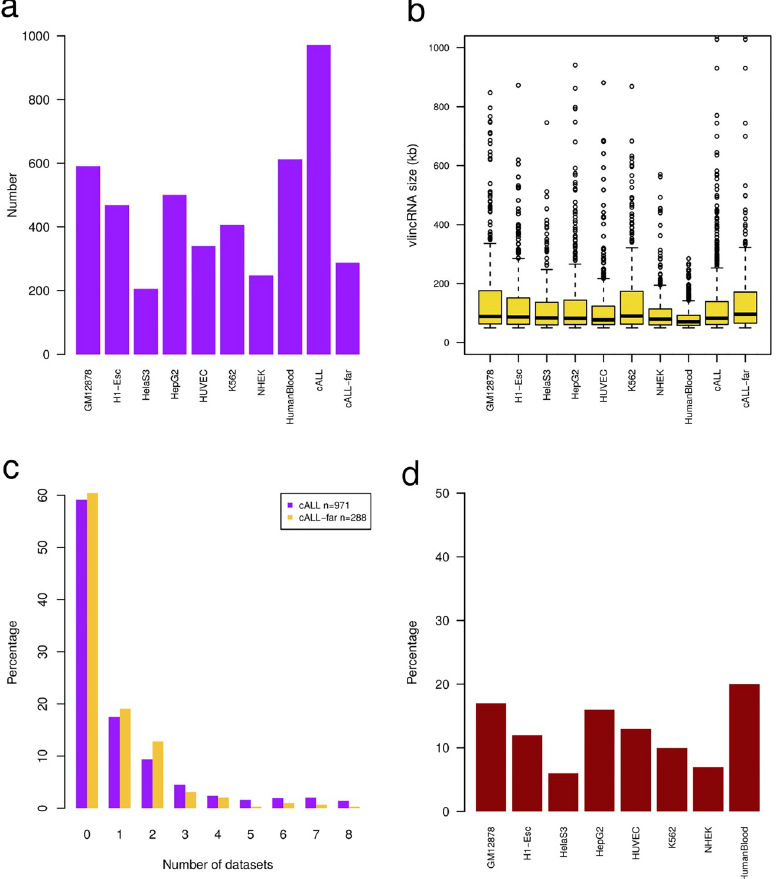
Fig 1. Characterization of cALL-derived vlincRNAs. (A) Number of vlincRNAs previously reported for diverse cell types (GM12878, H1-Esc, HelaS3, HepG2, HUVEC, K562, NHEK, HumanBlood) [9] and discovered in our cALL dataset, including ‘far-from-genes’ cALL vlincRNAs that are at least 10 kb away from protein-coding genes. (B) Boxplot of vlincRNA transcript sizes. (C) Percentage of all (n = 971) and ‘far-from-genes’ (n = 288) cALL vlincRNAs overlapping vlincRNAs a given number of public datasets. (D) Percentage of cALL vlincRNAs overlapping vlincRNAs from public datasets (HumanBlood data is unstranded).